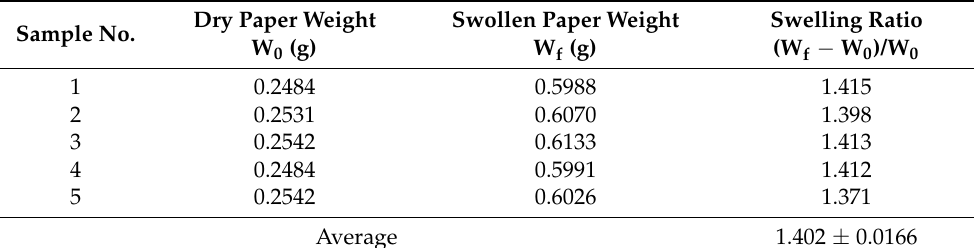
Table 2. Swelling ratio of coated antibacterial paper in deionized water. Sample